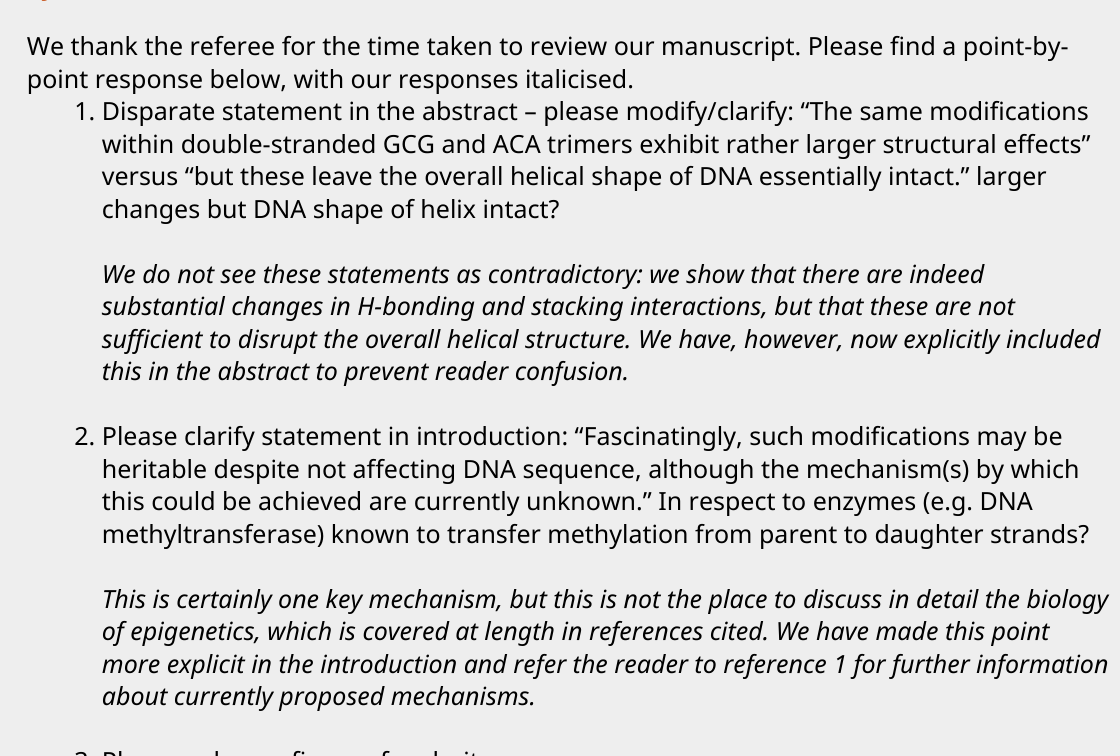
A: Fig 1: numbering of atoms, full name of modifications, example GC WC base pair geometry and info on parameters “role, rise twist